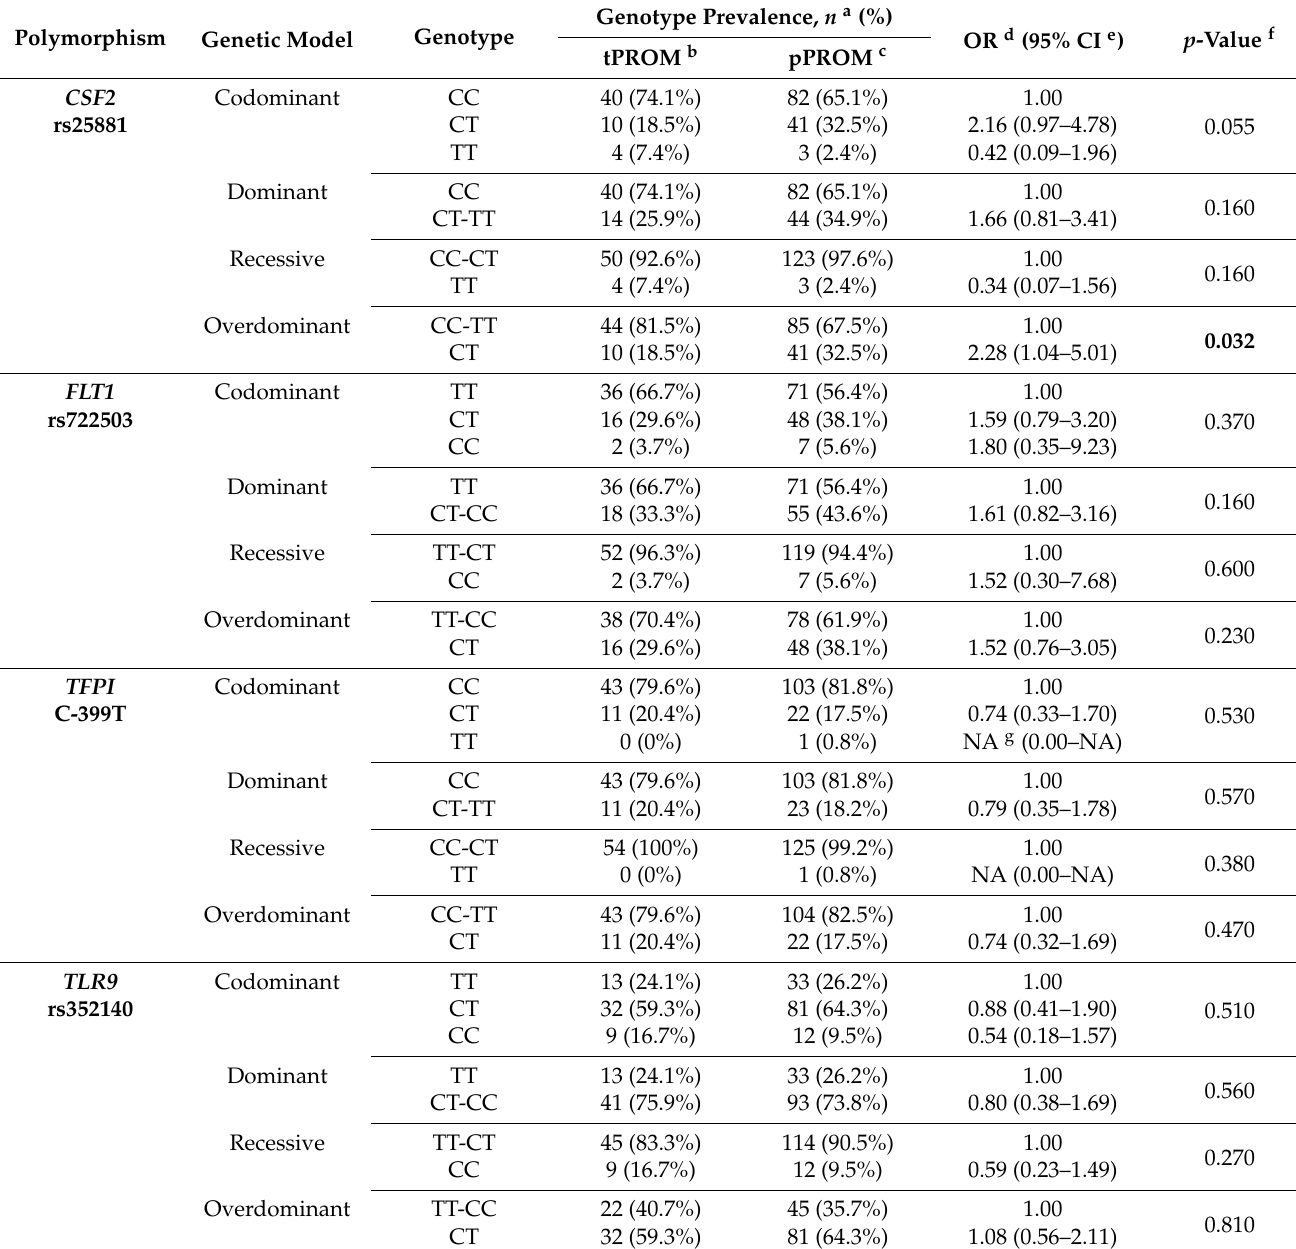
Table 2. Distribution of genotypes in CSF2 , FLT1 , TFPI and TLR9 SNPs between women with term and preterm PROM, adjusted for diabetes